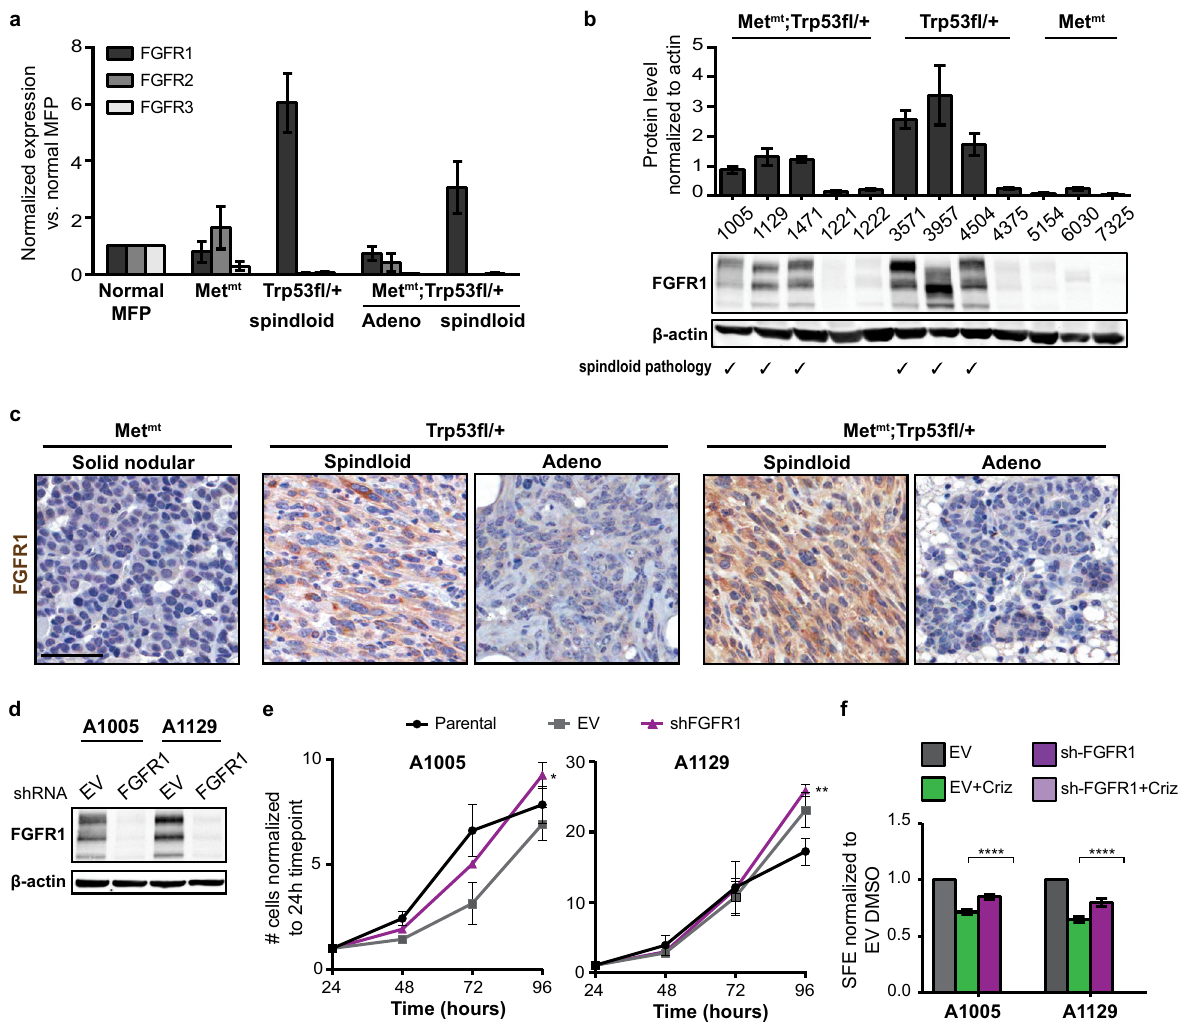
Fig. 3 FGFR1 is preferentially expressed in spindloid tumours and compensates for loss of Met signalling to sustain tumourspheres. a RNA extracted from MMTV- Met mt , Trp53 fl / + ; Cre and MMTV- Met mt ;Trp53 fl / + ; Cre tumour cells was used to assess relative expression levels of FGFR1, 2 and 3 using quantitative RT-PCR. b Western blot analysis to validate FGFR1 expression at the protein level. The pathology of each tumour-derived cell line tested ( n = 3 for MMTV- Met mt , n = 4 for Trp53 fl / + ; Cre and n = 5 for MMTV- Met mt ;Trp53 fl / + ; Cre tumours) is indicated. c Paraf fi n-embedded sections of corresponding tumours were analysed by immunohistochemistry for FGFR1 expression ( n = 3). Representative images are shown. Scale bar: 50 μ m. d A1005 and A1129 cells were transfected with empty vector or shRNA against FGFR1, and ef fi cient knockdown of FGFR1 was veri fi ed by western blot analysis ( n = 3). e The effect of FGFR1 knockdown on proliferation in adherent condition was assessed for 96 h by Trypan blue assay ( n = 3). f The effect of FGFR1 knockdown on tumoursphere formation in the presence or absence of 1 μ M Crizotinib was assessed after 5 days of culture. Student ’ s t test; * P ≤ 0.05; ** P ≤ 0.01. Error bars indicate